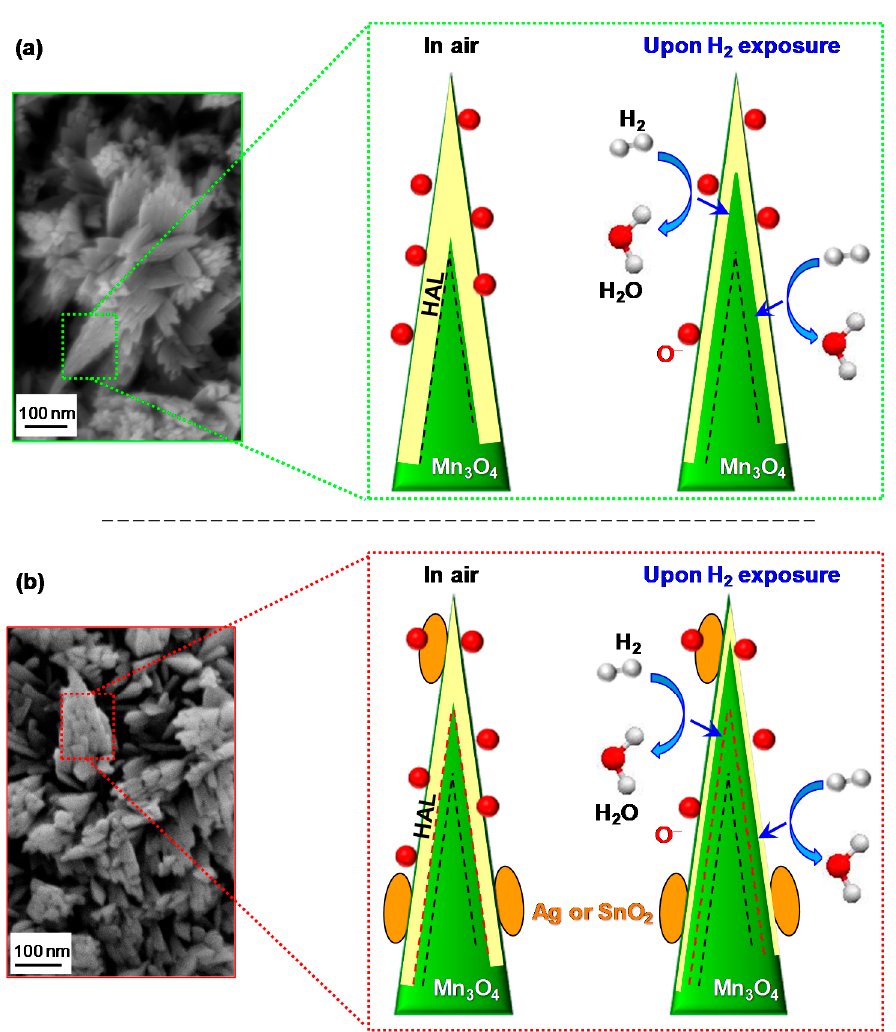
Figure 7. Schematics of the hydrogen gas sensing mechanism and corresponding hole accumulation layer (HAL) modulation for nanosystems based on: ( a ) bare Mn 3 O 4 ; ( b ) functionalized Mn 3 O 4 . The dashed black and red lines indicate the HAL boundaries in air in case of bare and functionalized Mn 3 O 4 , respectively. Red spheres, yellow areas, and orange ovals indicate adsorbed oxygen, HAL thickness, and functionalizing agent (Ag or SnO 2 ), respectively. Blue arrows indicate electron flow due to H 2 oxidation (see reaction 4).